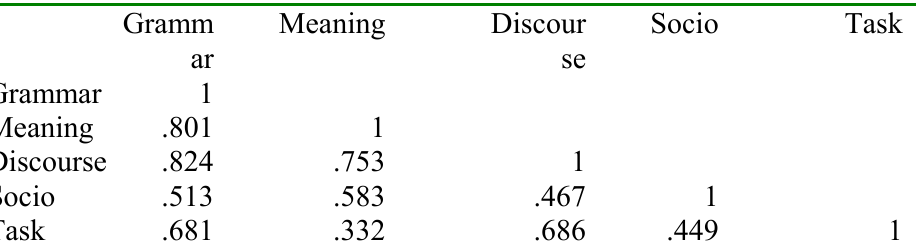
Correlation Analyses for the High Proficiency Group